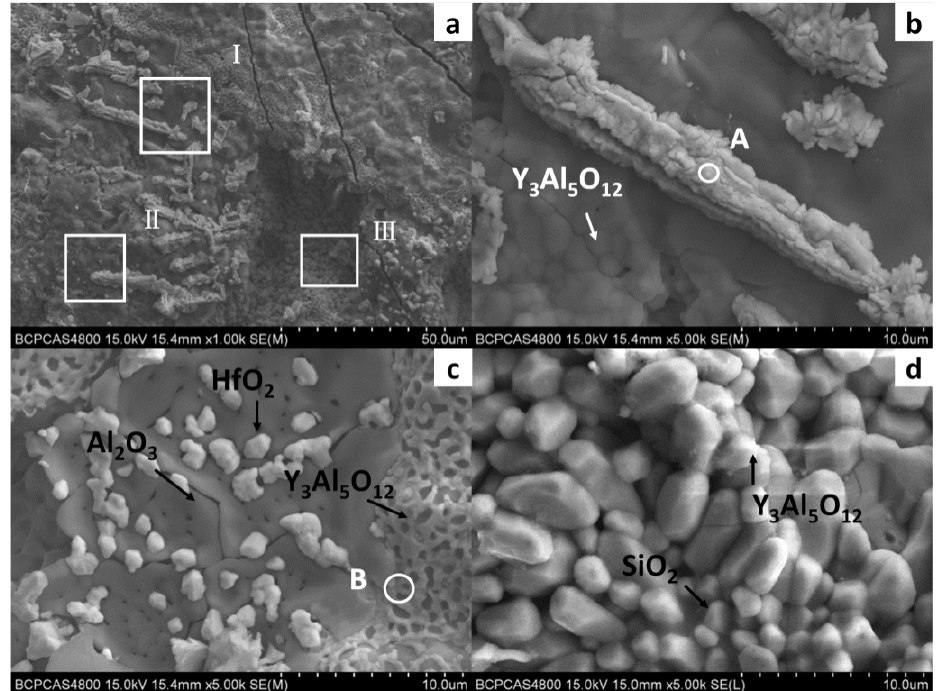
Figure 5. The interfacial reaction between DD6 and Y 2 O 3 mould: ( a ) cross-Section of mould; ( b ) high magnification of zone I ; ( c ) high magnification of zone II; ( d ) high magnification of zone III .